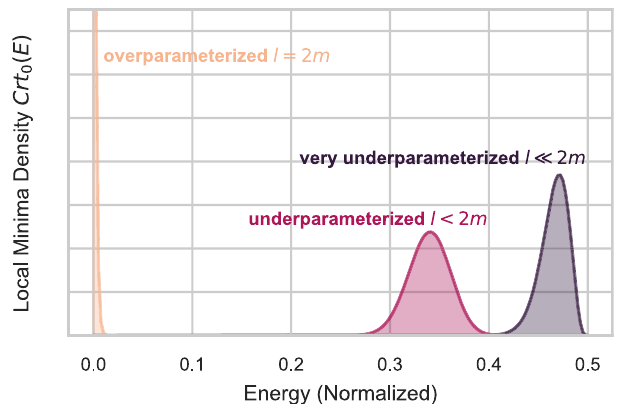
Fig. 4 | Characteristic distribution of local minima. Plot of the asymptotic dis- tributionoflocalminimaofWHRFswith m degreesoffreedomonthe l -torusin:the extremely underparameterized regime, where l ≪ 2 m ; the moderately under- parameterized regime, where l is a fi nite fraction of 2 m ; and at the critical over- parameterizationregime,where l =2 m .Here,theenergyisscaledandshiftedasper (9)sothatglobalminimahavezeroenergy.Intheunderparameterizedregime,only afraction ∼ exp (cid:3) m ð Þ ofthecriticalpointsarewithinanyconstantadditiveerrorof the global minimum. In the overparameterized regime, local minima are expo- nentially concentrated at the global